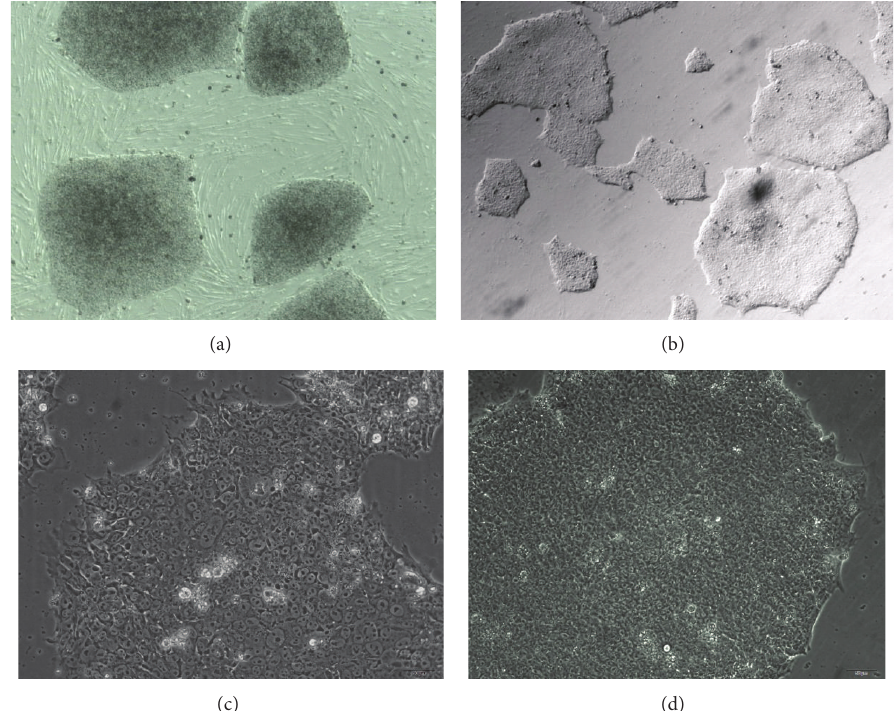
Figure 1: hESCs were grown on irradiated feeder cells, Matrigel, or methanol fixed xeno-free ECM. (a) hESCs were grown on irradiated MEF feeder cells in KSR complete medium (10x); (b) hESCs were grown on fixed xeno-free ECM in TeSR-E8 (10x); (c) hESCs were grown on Matrigel in TeSR-E8 (20x); (d) hESCs were grown on fixed xeno-free ECM in TeSR-E8 (20x).